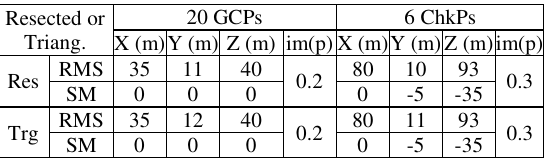
Table 3. GLAS (5 posts) Errors at GCPs and ChkPs Resected or Triang.